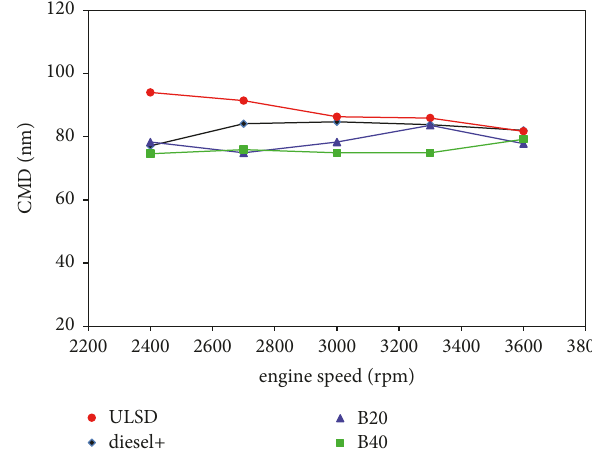
Figure 10: NO variation with engine speed at 80% load.